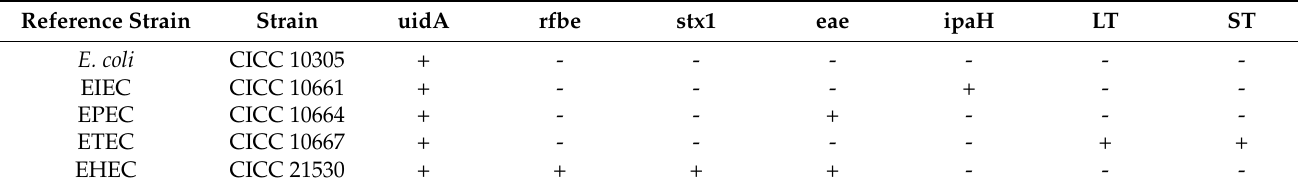
Table 1. Specific target molecules corresponding to pathogenic bacteria. Reference